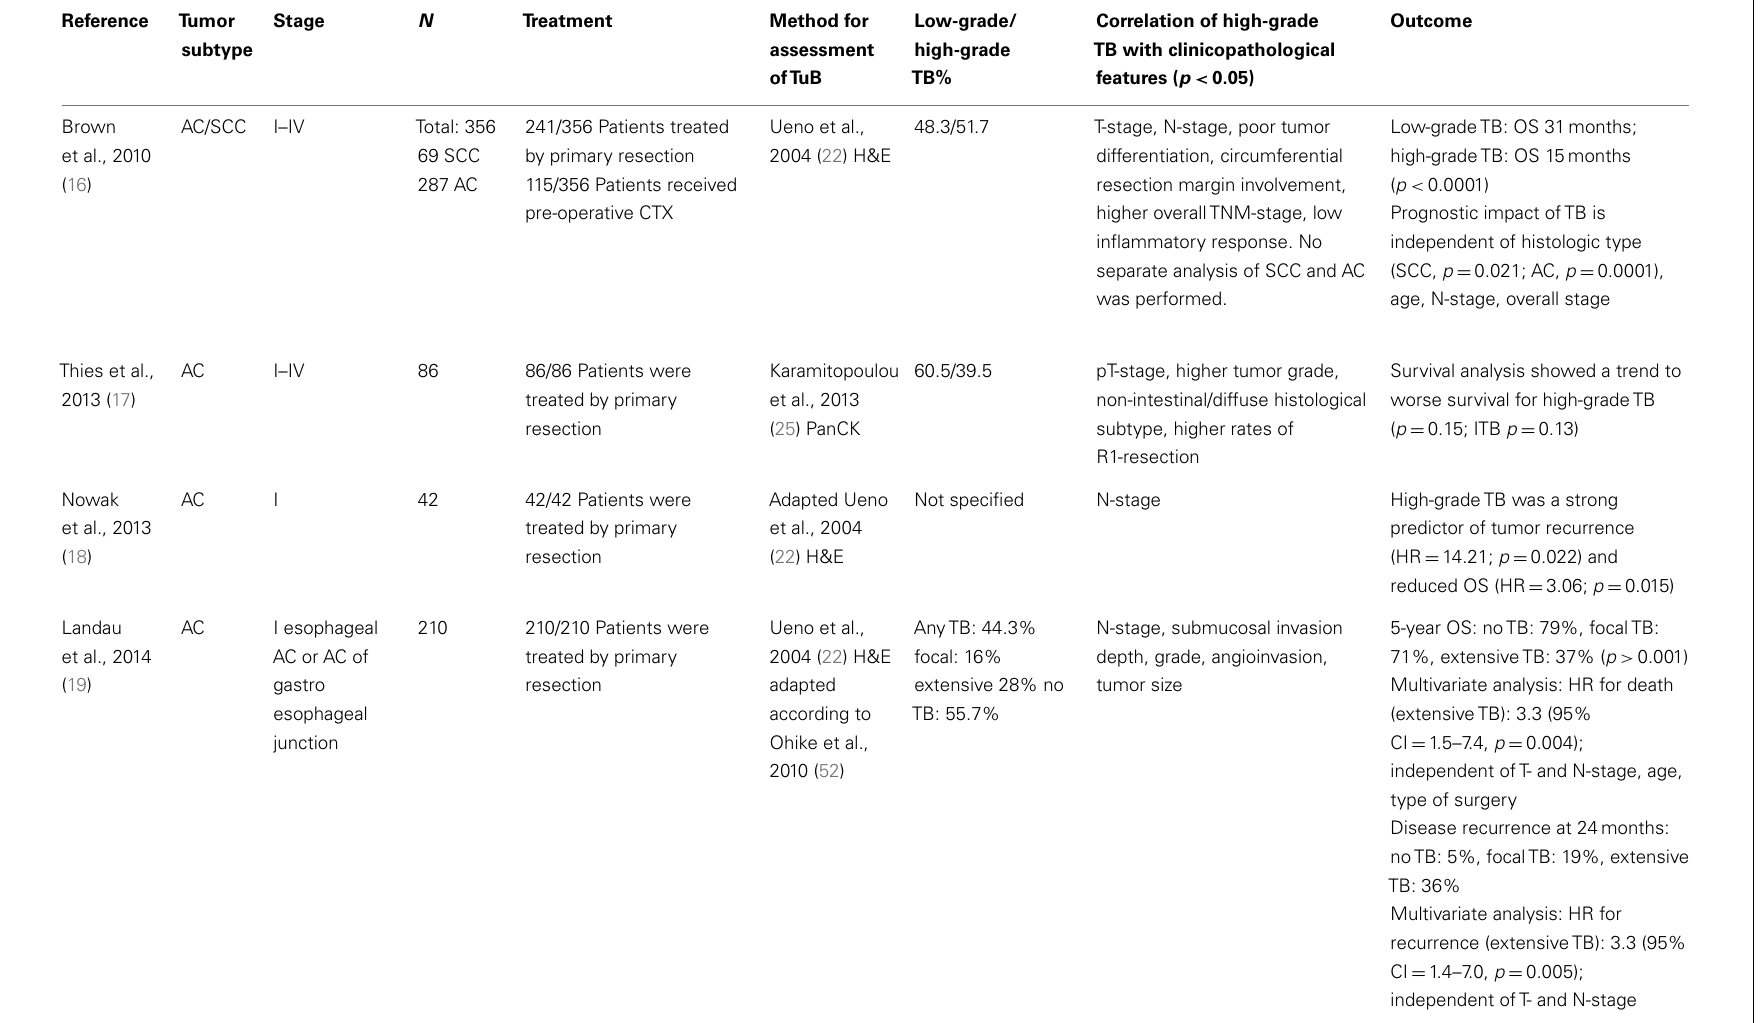
Table 3 | Studies on tumor budding as a histomorphological prognostic factor in adenocarcinoma of the esophagus